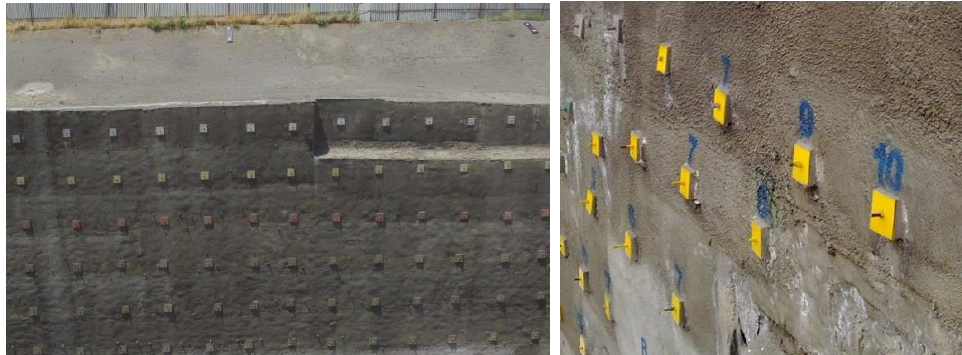
Figure 4. An example of wall nailing and the metal plate attached to the nails.